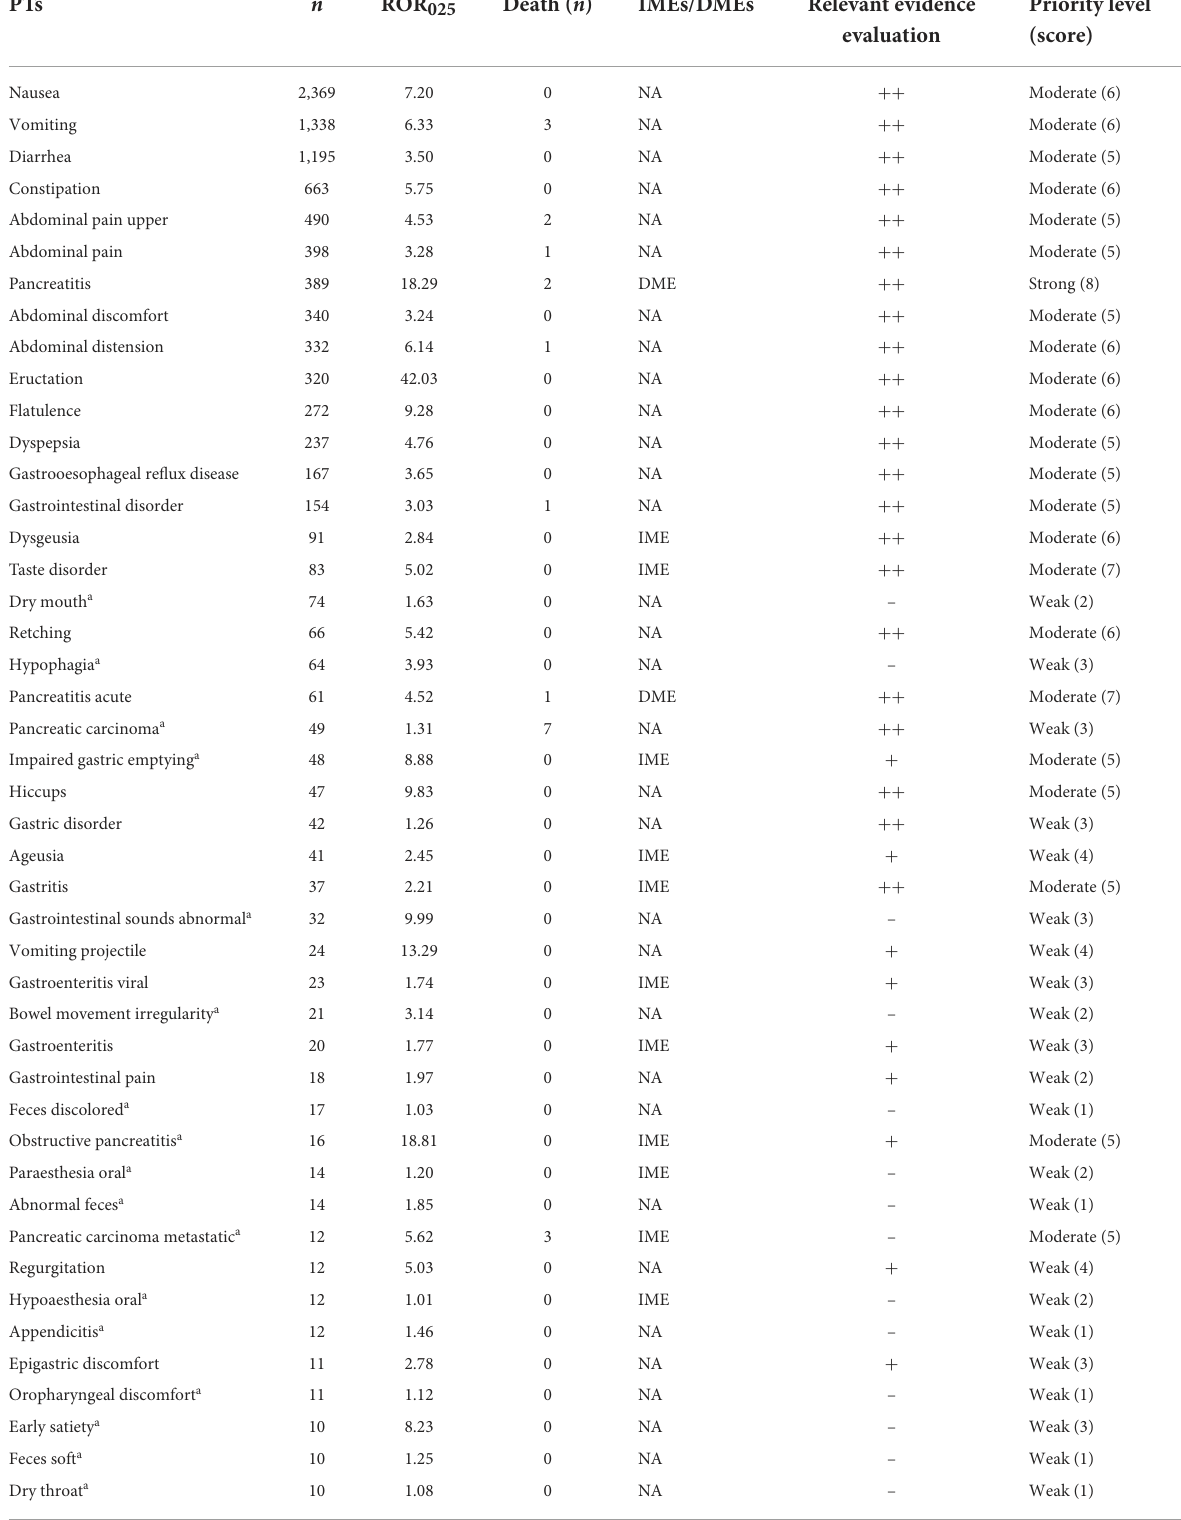
TABLE 3 Clinical priority assessing results of disproportionality signals. PTs n ROR 025 Death ( n ) IMEs/DMEs Relevant evidence